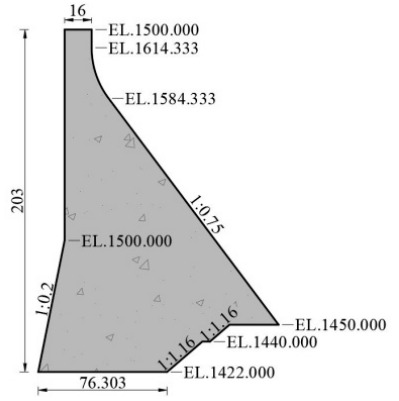
Figure 6. Geometry of the dam (m).